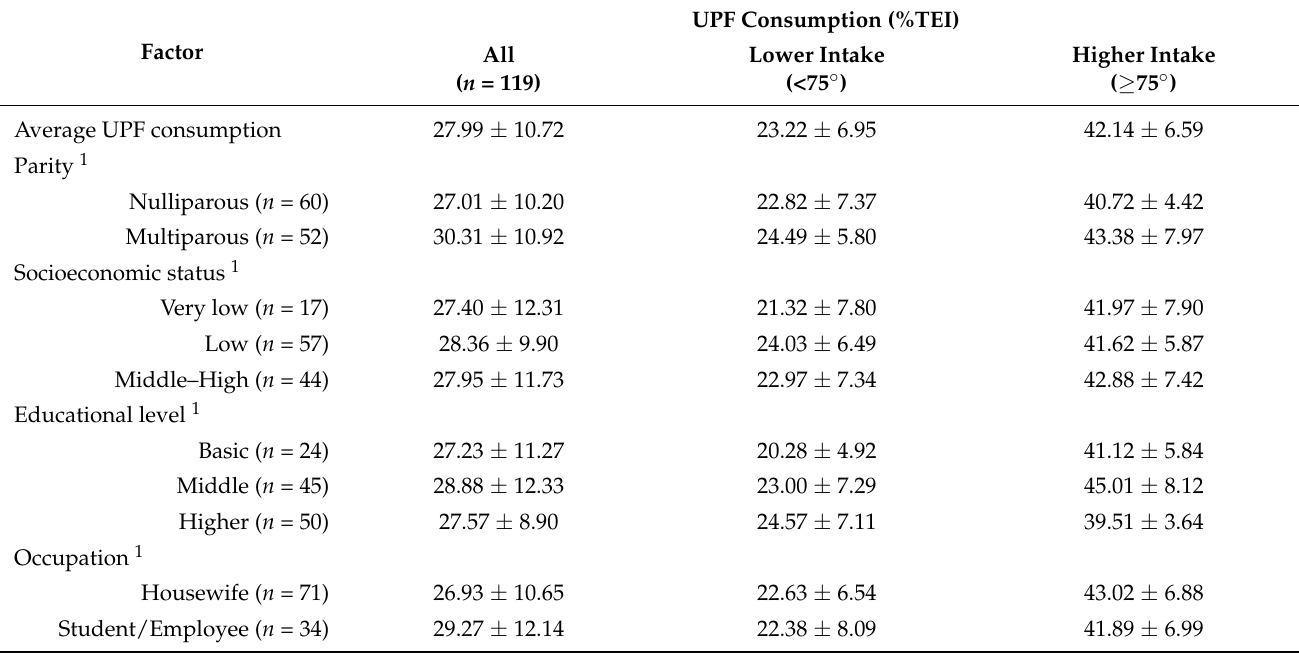
Table 1. Consumption of UPFs according to maternal clinical and sociodemographic